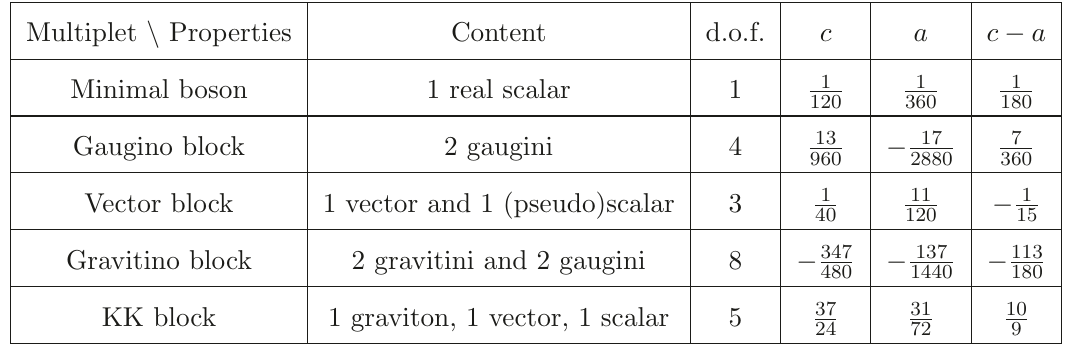
Table 7 . Contributions to a 4 ( x ) decomposed in the multiplets that are natural to the KK black hole.